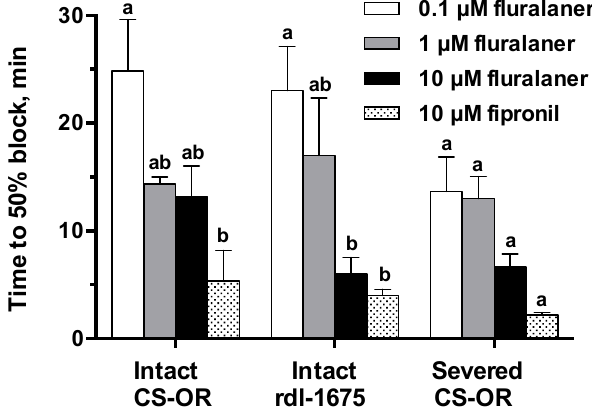
Figure 7. Time to 50% reduction of firing rate after chemical treatments of D. melanogaster larval CNS preparations. Each bar is the average of at least three replicates and error bars show ± SEM. Letters indicate statistical significance at the p = 0.05 level using a two-way ANOVA calculated with Prism software. Comparisons were made across different treatments within a nerve preparation ( p < 0.0001) as well as for a given treatment across the different CNS dissections ( p = 0.1263). Bars not labeled by the same letter are significantly different.